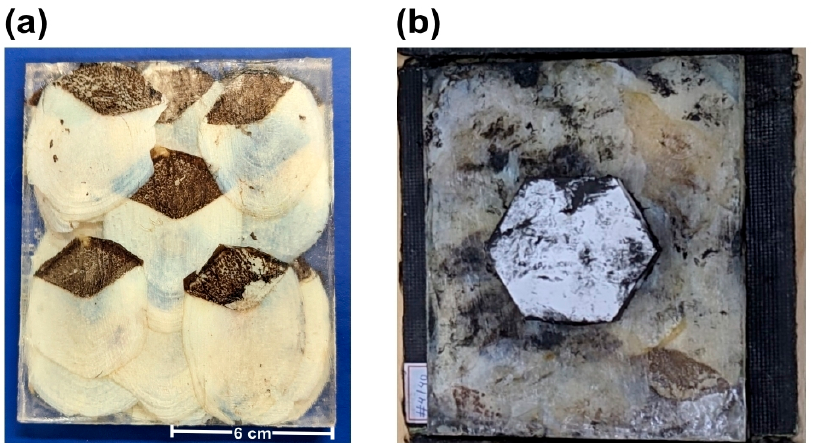
Figure 2. Fabricated plate of arapaima scales-reinforced epoxy composites ( a ); assembled multilayered armor system (MAS) using the arapaima scales-reinforced composite plates as the second layer ( b ).